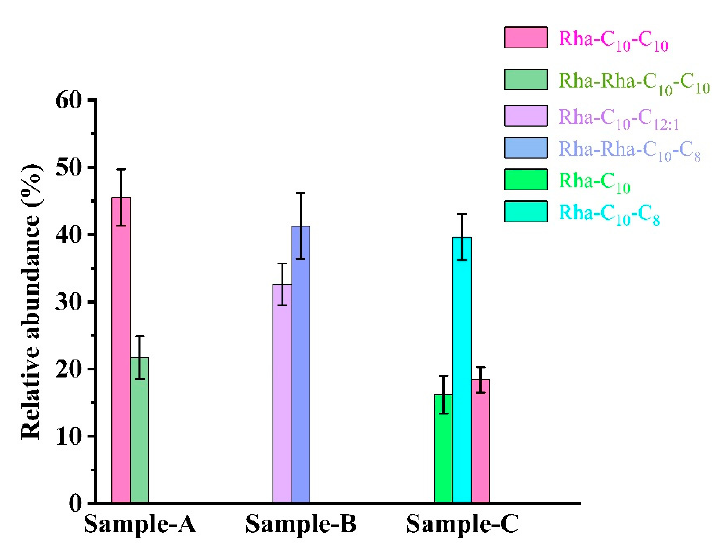
Figure 5. The main structures and relative abundances of rhamnolipids obtained from Sample A, Sample B and Sample C. Sample A: the rhamnolipid sample obtained from P. aeruginosa SW1 in Erlenmeyer flasks without pH control. Sample B: the rhamnolipid sample obtained from P. aeruginosa SW1 by fermenter with fermentation controlled at pH 5.5. Sample C: the rhamnolipid sample obtained